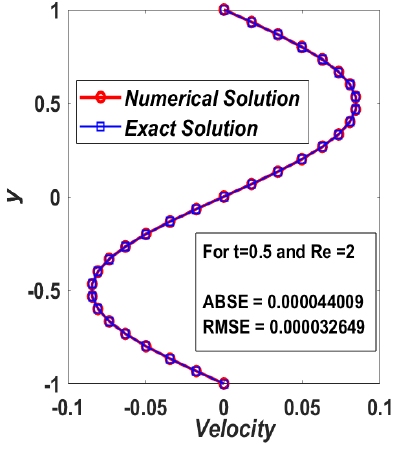
Figure 4. Comparison of present numerical result with an exact solution at